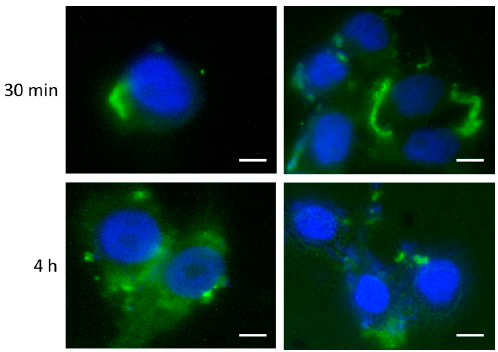
Figure 6. Immunofluorescent detection of digested gliadin uptake in Caco-2 cells. Caco-2 cells were fixed at different times after digested gliadin administration (i.e., 30 min and 4 h). Coverslips were then incubated with anti-gliadin primary antibody followed by a secondary AlexaFluor 488 antibody. Nuclei are stained with DAPI. Size bars are 10 µm.